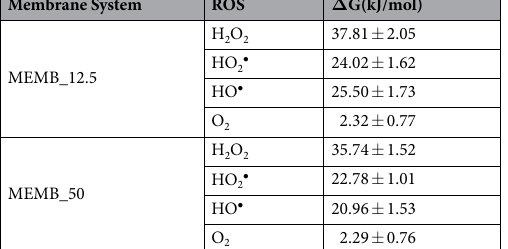
Table 2. Transfer free energies ( Δ G) of all investigated ROS in the oxidized skin-bilayer lipid (CER-CHO-FFA- 5 α -CH)